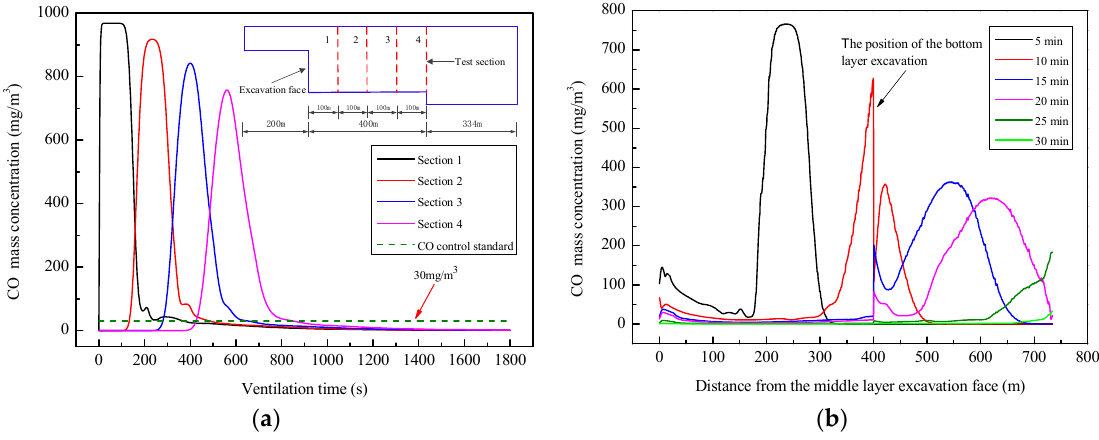
Figure 14. ( a ) CO concentration in monitoring section with ventilation time; ( b ) CO concentration distribution at the breathing height.